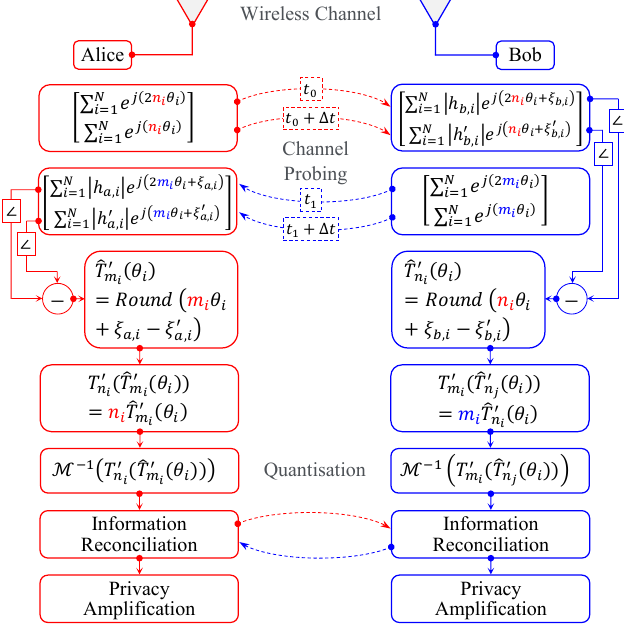
Figure 1. The PHY-layer secret key extraction scheme in a noiseless